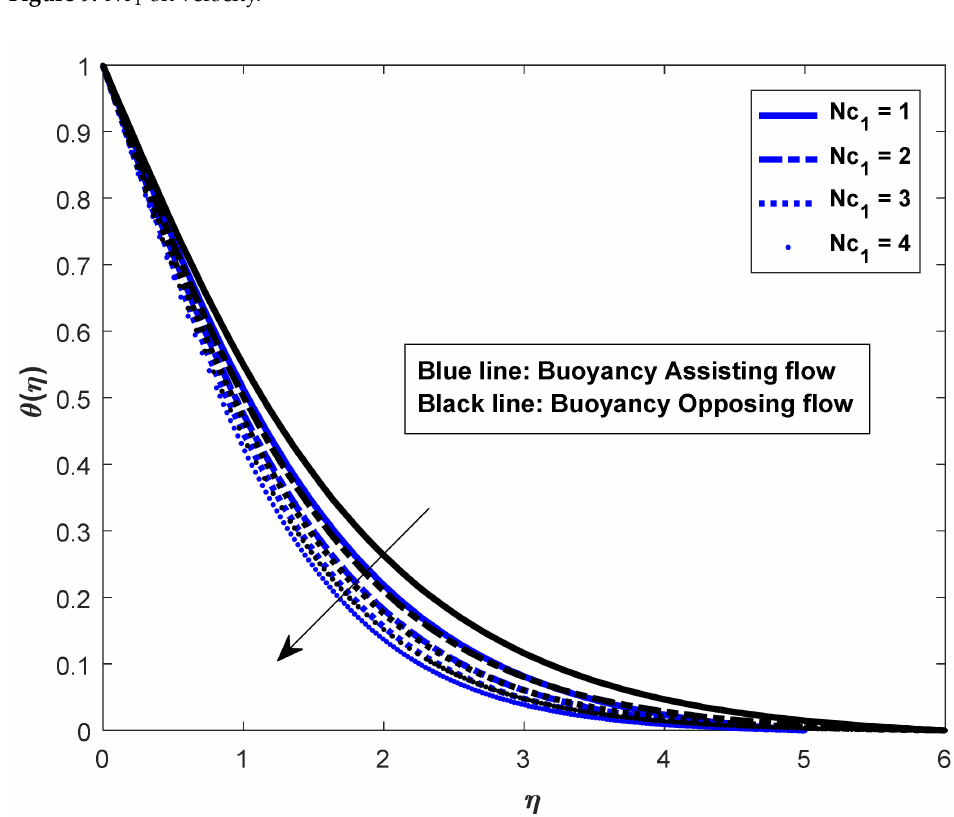
Figure 9. Nc 1 on velocity.